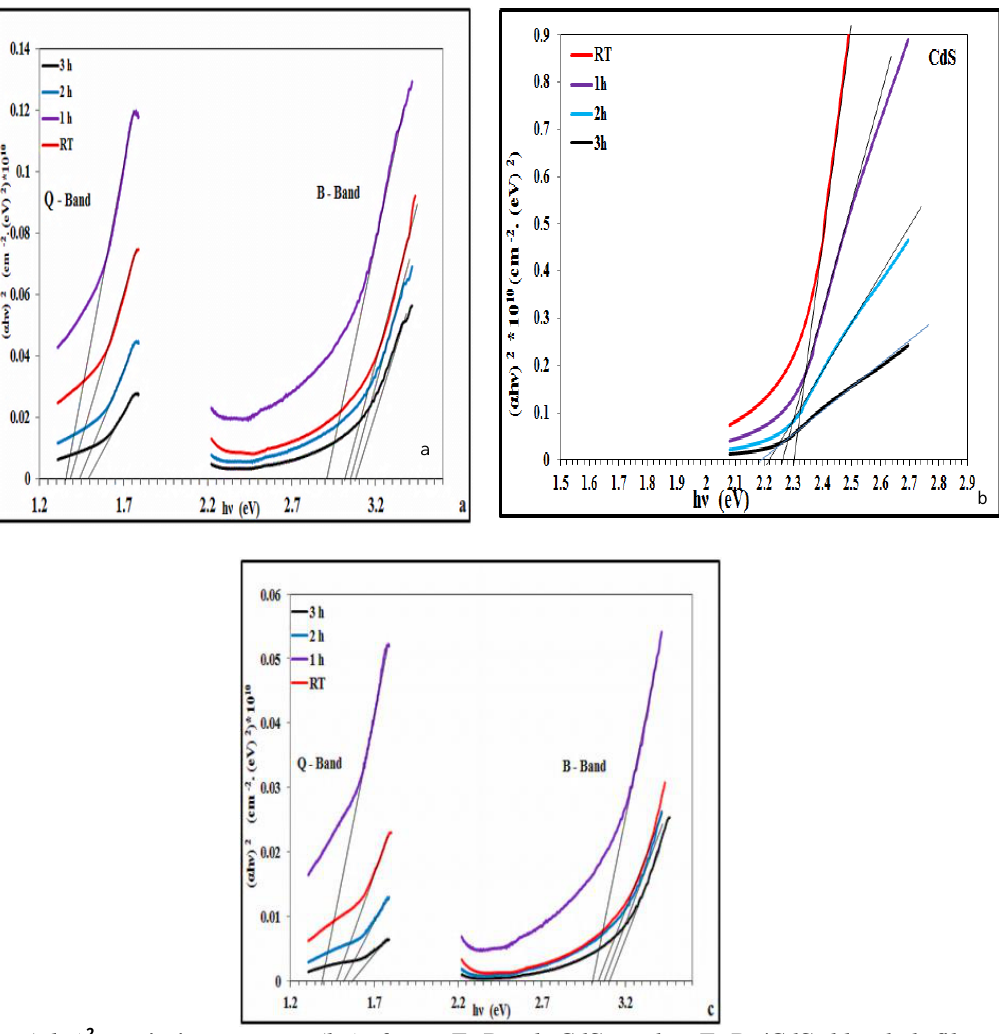
Fig.2: (αhυ) 2 variation versus (hυ) for a:ZnPc, b:CdS and c:ZnPc/CdS blended films at different annealing time at 423 K. Table 1: The values of E for as-deposited and annealed ZnPc, CdS and ZnPc/CdS blend films g for 423K at different annealing